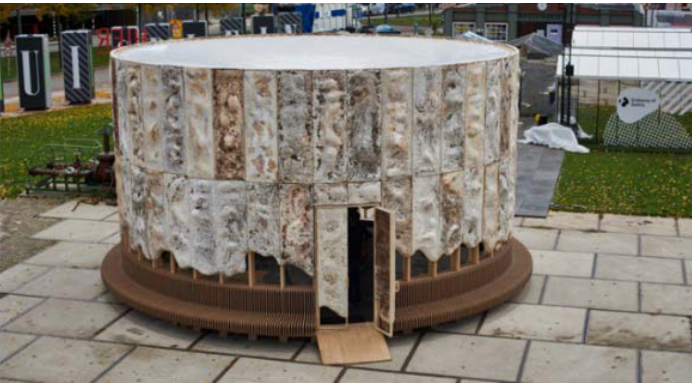
Figure 14 The Growing Pavilion-2019